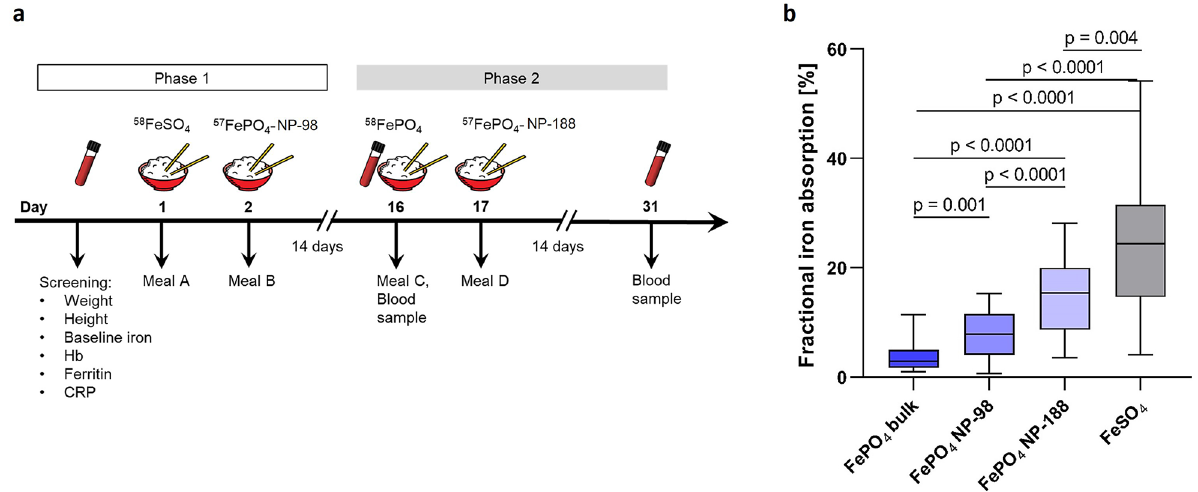
Figure 5. Iron bioavailability of two 57 Fe-labeled FePO 4 -NP in iron deficient anemic women (n = 18). (a) Outline of randomized cross-over study. ( b) Fractional iron absorption (%) from rice test meals fortified with FePO 4 -NPs (SSA 98 m 2 g −1 and 188 m 2 g −1 ) labeled with a stable isotope ( 57 Fe), and 58 Fe-labeled bulk FePO 4 (SSA 25 m 2 g −1 ) and FeSO 4 as negative and positive reference compounds, respectively. Meal sequence